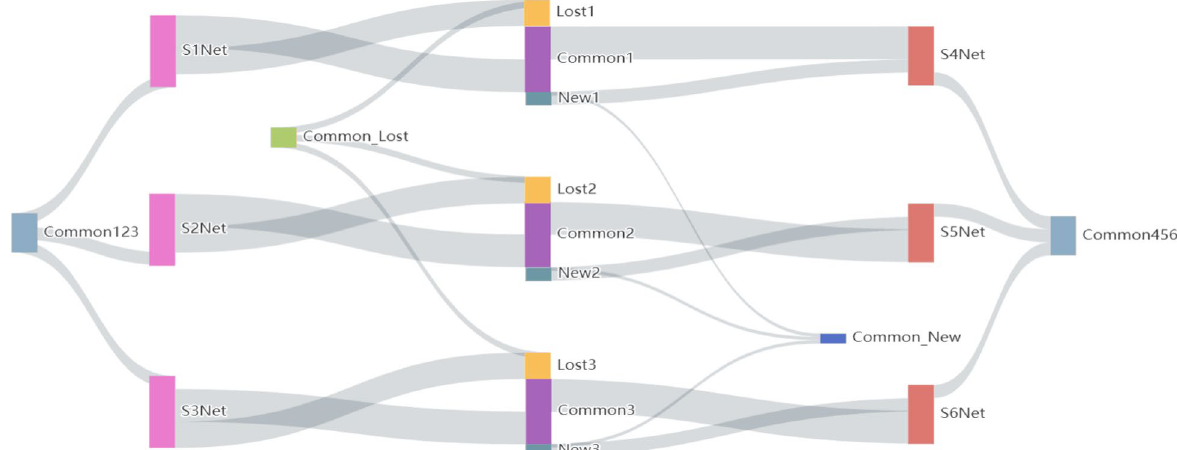
Fig. 6 Differences in the interaction among three pairs of active networks. Note: Common123 presents the same interactions at high oxygen levels in the experiment, Common456 presents the same interactions at low oxygen levels in the experiment, Common_Lost presents the same interactions in which three pairs of active networks disappear together, and Common_New presents the same interactions in which three pairs of active networks add together. In S1Net and S4Net, Common1 represents common interactions, Lost1 presents interactions that disappear after the change in experimental conditions, and New1 presents interactions that are newly added after the change in experimental